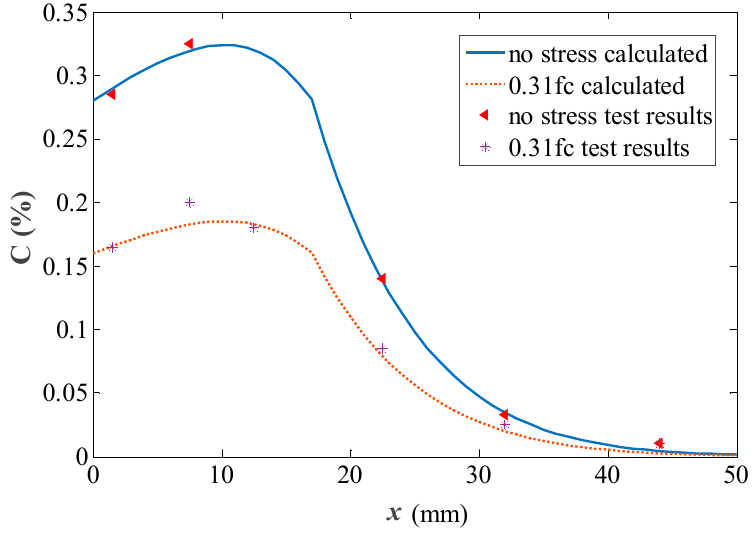
Figure 2. Experimental data fitting.